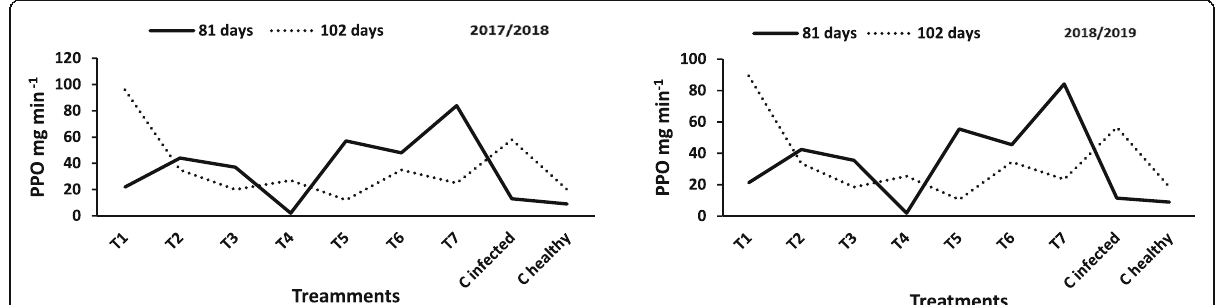
Fig. 5 Polyphenol Oxidase (PPO) activities for different treatments at two seasons. T1 = AgNps 50 ppm, T2 = AgNps 75 ppm, T3 = AgNps 100 ppm, T4 = Spirulina 50%, T5 = Spirulina 75%, T6 = Spirulina 100% and T7 = Bacillus